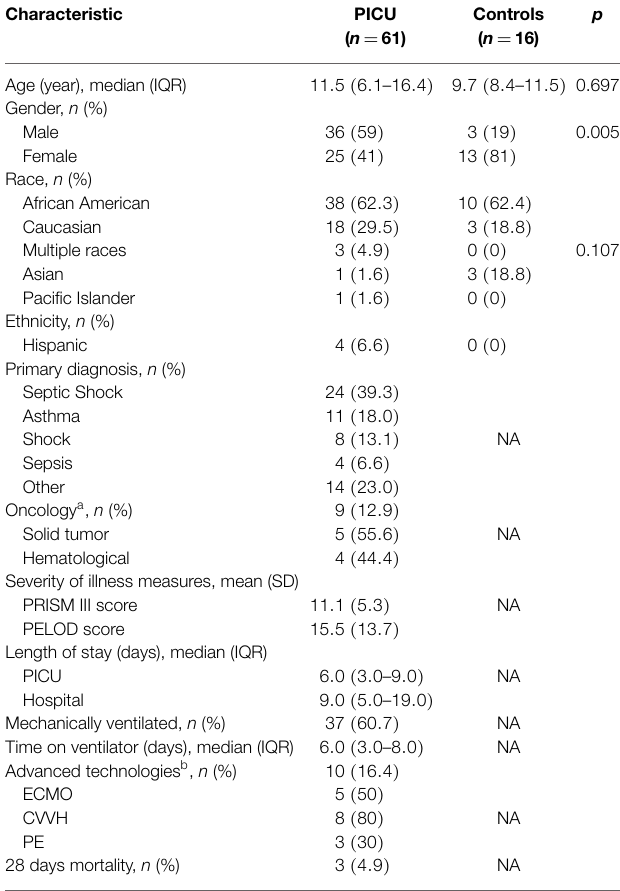
TABLE 1 | Demographics, primary diagnosis, and severity of illness mea- sures .